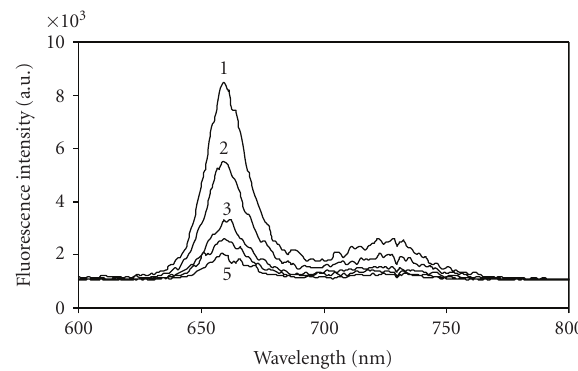
Figure 4: Time-resolved laser-induced fluorescence emission spec- tra of TPPOH O in benzene at room temperature registered 0, 5, 10, 15, and 20 nanoseconds (resp., curves 1 to 5) after laser pulse, at 337nm. The spectrum was registered with a gate of 100 nanoseconds for air equilibrated